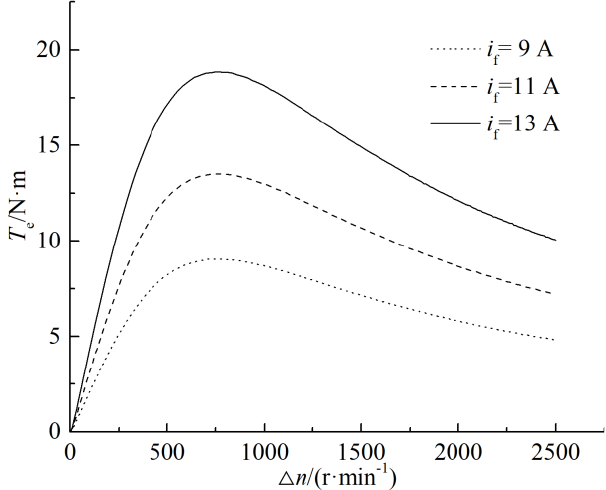
Figure 6. Curves of the speed difference-electromagnetic torque relationships.